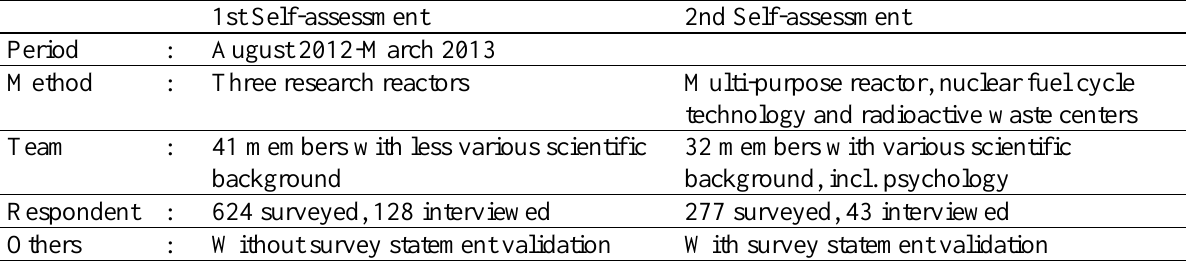
Table 1. Summary of Self-Assessment Conduct in BATAN with survey statement